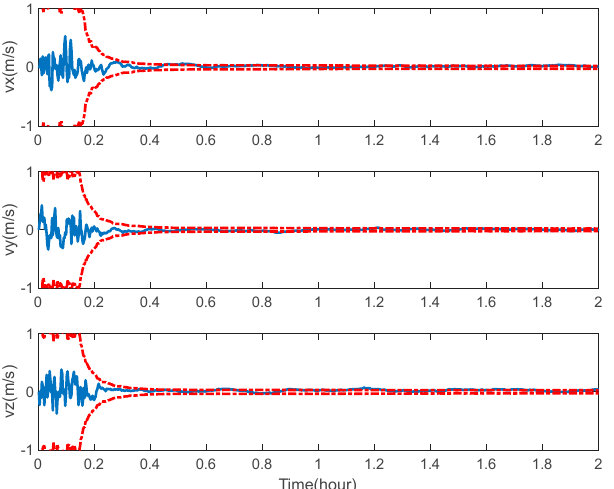
Figure 14. Position error of space-target-based INS/Vision integrated navigation.